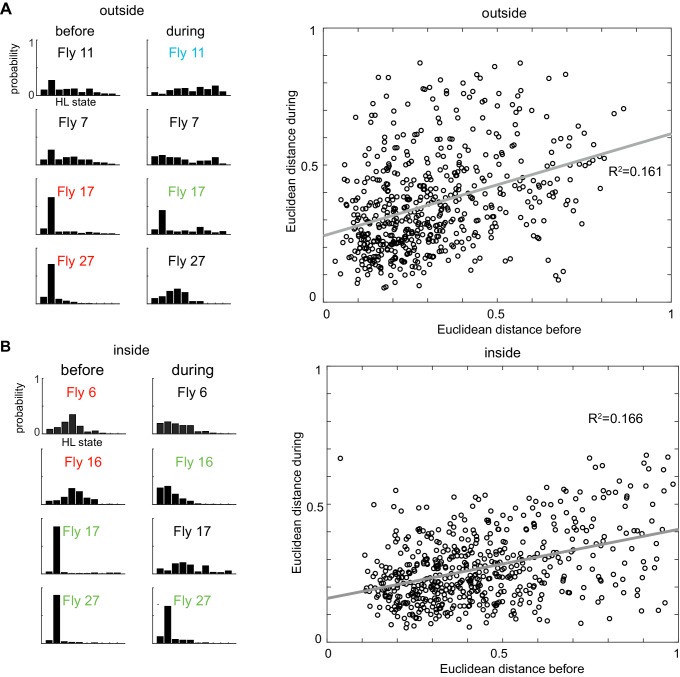
Locomotion before odor onset is only weakly predictive of locomotion during the presence of odor.(A) Left: X-means clustering algorithm based on the average HL state distribution for each fly before the odor period and inside the odor ring grouped the 34 flies into three different clusters. Flies belonging to the same cluster, like 11,7 and 17,27 showed similar HL state distributions. The same algorithm grouped the flies in three different clusters during the odor period and inside the odor ring. The flies which belong to the same cluster before the odor period belong to different clusters following odor and show very different HL state distributions from each other. Right: Linear regression analysis between the Euclidean distances before and during the odor period outside the odor ring shows that they are weakly correlated with a r-squared value of 0.161 (p < 0.001). (B) Left: The same analysis was applied to the inside odor case. Again, flies belonging to the same cluster 6,16 and 17,27 before first entry showed different distribution of HLS usage following odor. Right: Linear regression analysis between the Euclidean distances before and during the odor period inside the odor ring shows that they are weakly correlated with a r-squared value of 0.166 (p < 0.001).